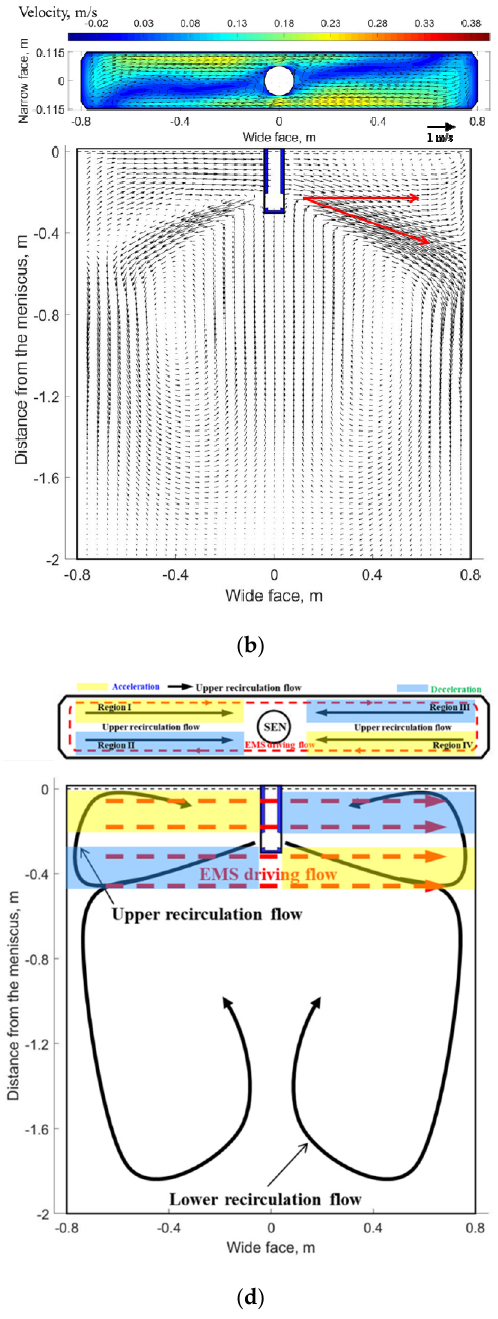
Figure 5. Velocity distribution at transverse plane (plane 1) and a quarter longitudinal plane (plane 2): ( a ) without-EMS, ( b ) 400 A-EMS, ( c ) 700 A-EMS ( d ) schematic of flow pattern with EMS.